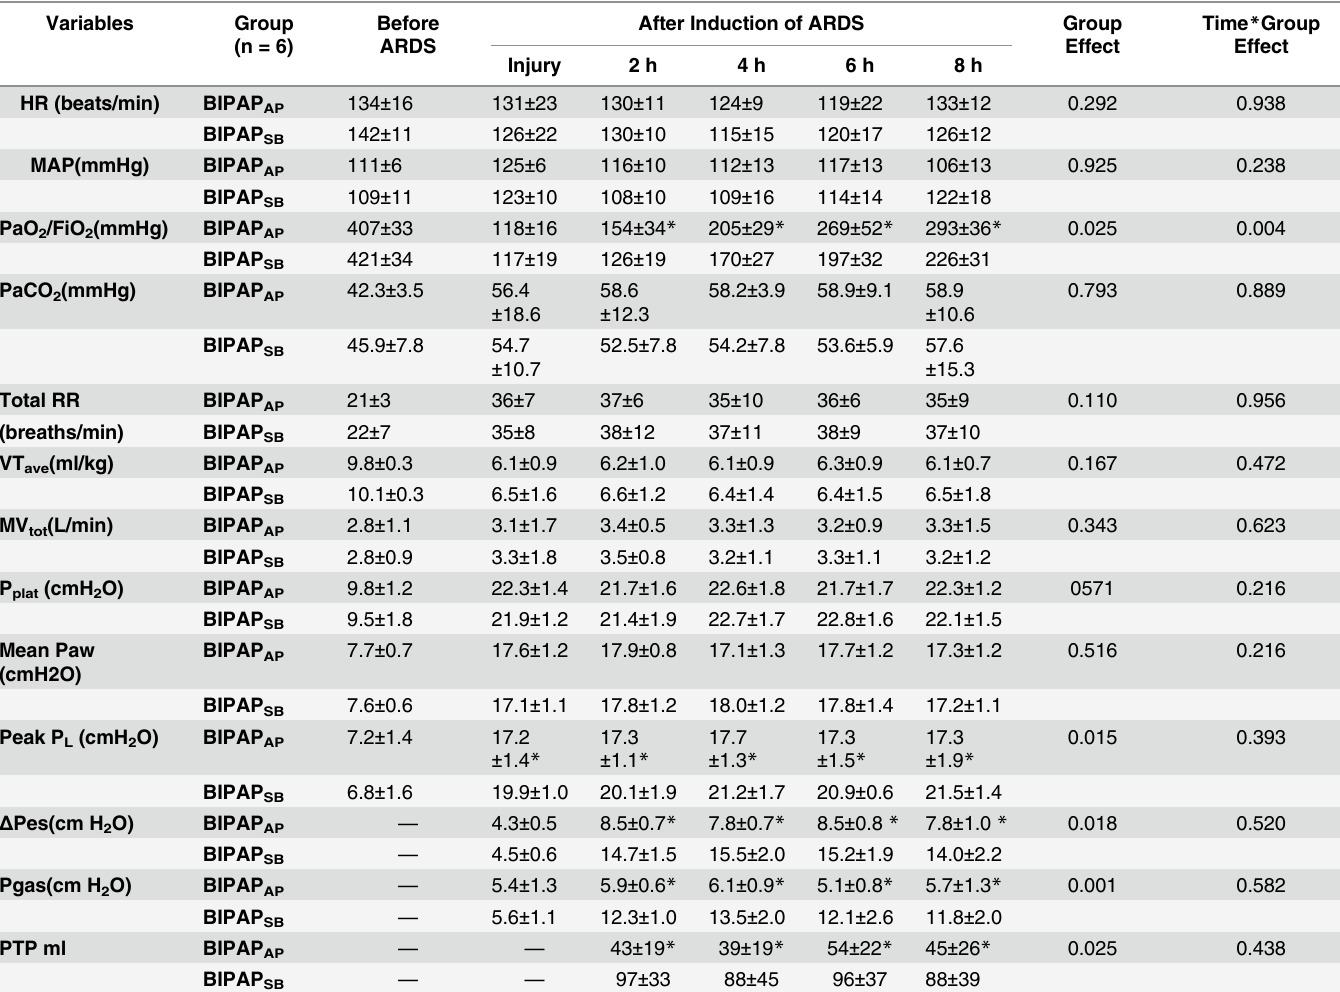
Table 1. Respiratory